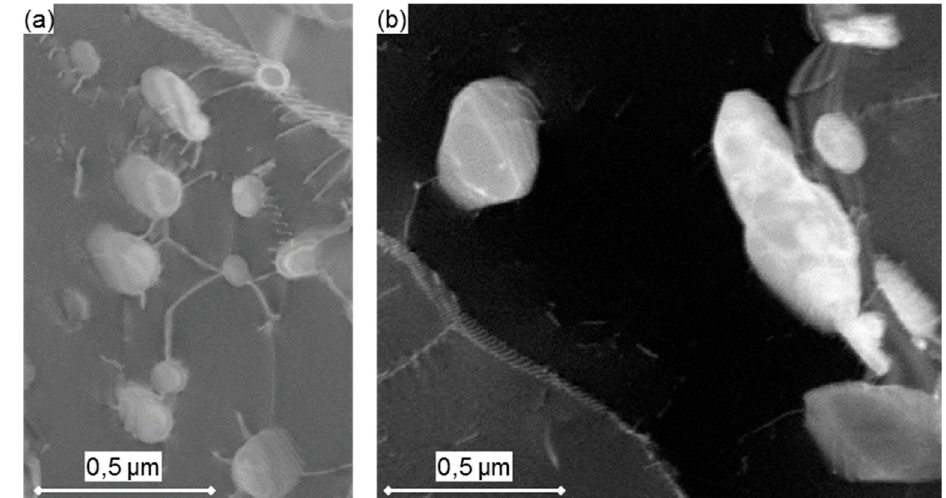
Figure 19. ADF-STEM images showing ( a ) multi-particle pinning of dislocations by M 23 C 6 particles closely spaced together in the EXL material and ( b ) dislocations bypassing larger precipitates spaced further apart in the EXH material. further apart in the EXH material.